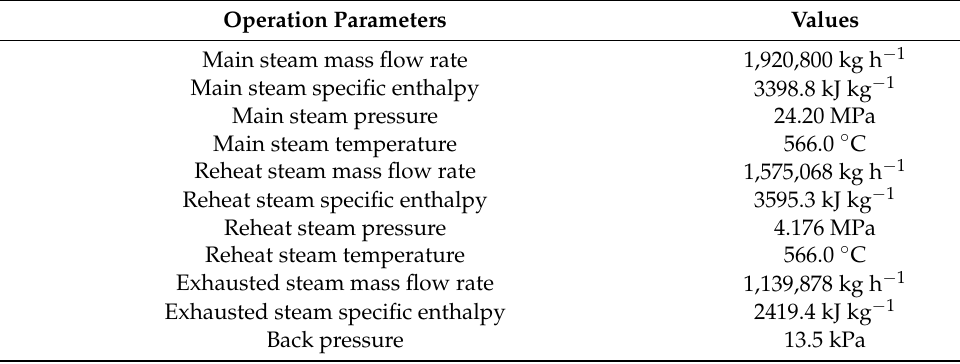
Figure 1. Schematic of the thermal–fluid process of the indirect dry cooling power plant. Table 1. Designed parameters of the power